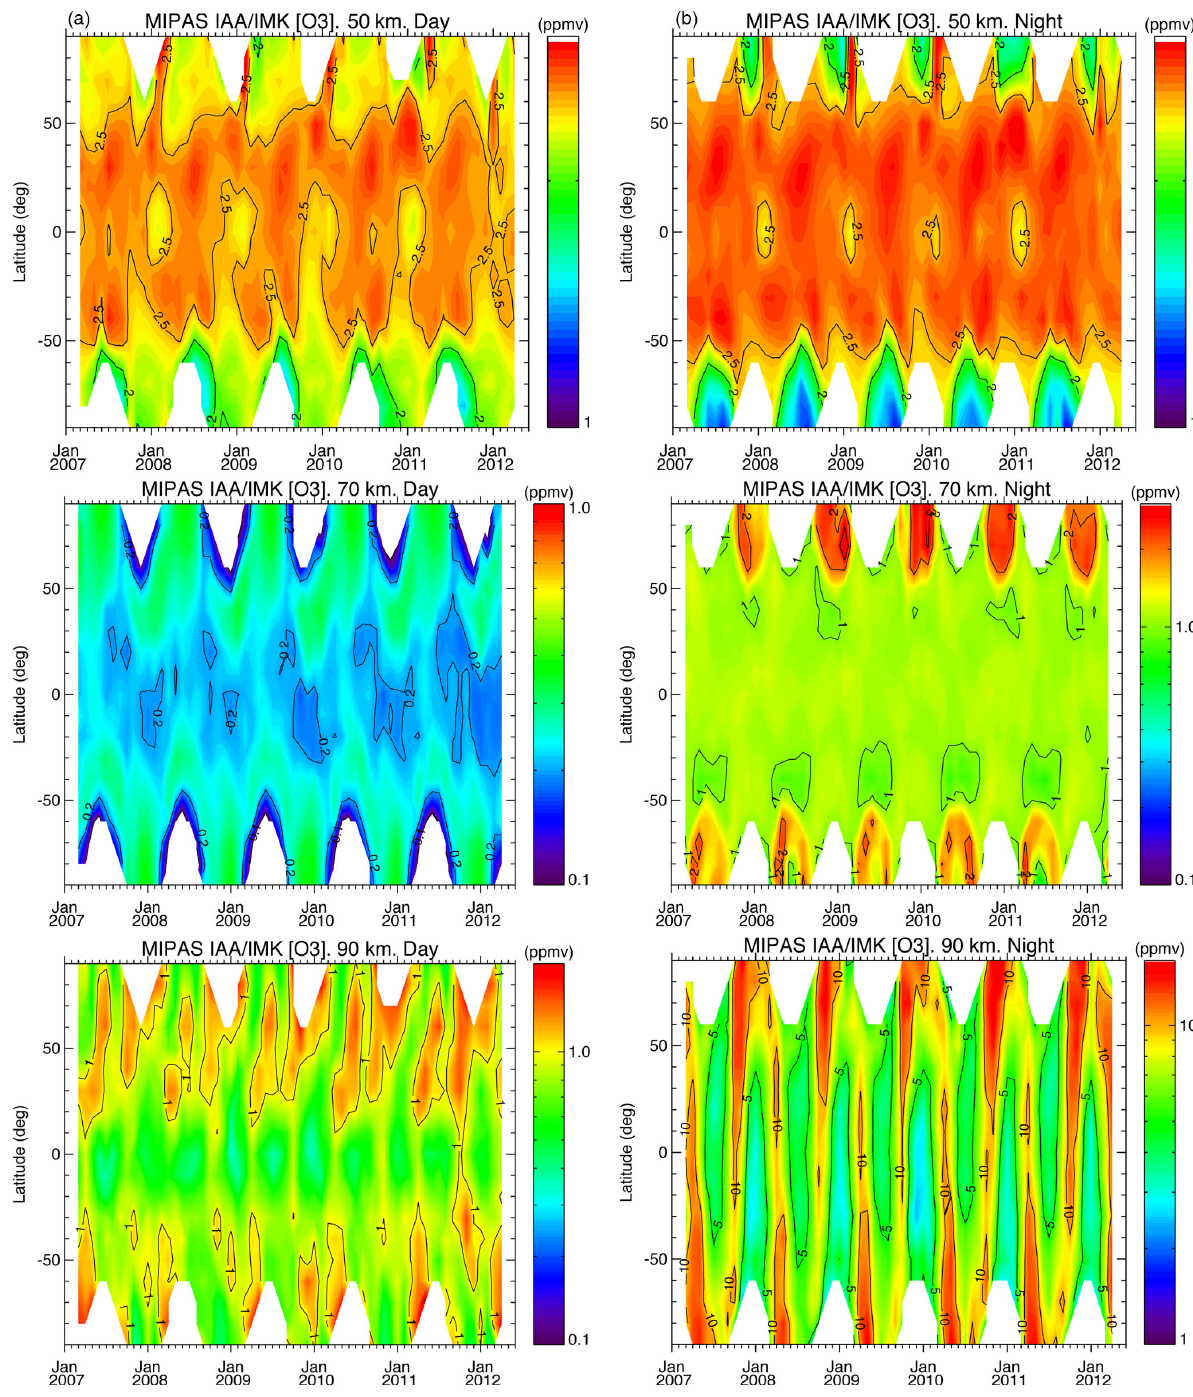
Figure 16. Cross section of latitude–time MIPAS O 3 at 50, 70 and 90km for daytime (a) and nighttime (b) . Note the different colour scales in some